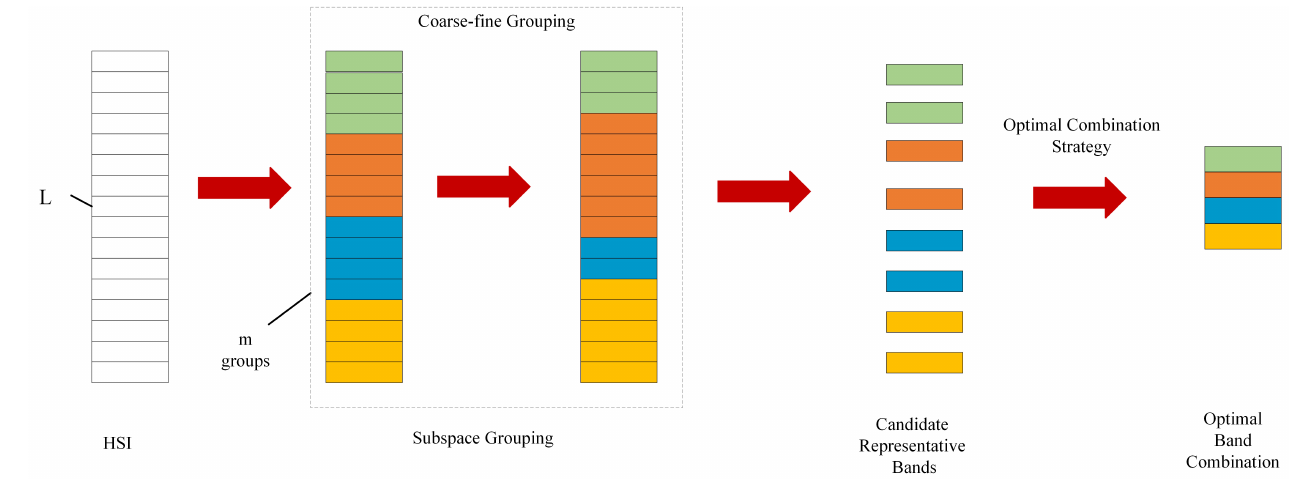
Figure 2. Flowchart of OCS. All bands are divided into m groups by coarse–fine grouping. In addition, two candidate representative bands are searched in each subspace and the two search strategies are utilized to obtain the optimal